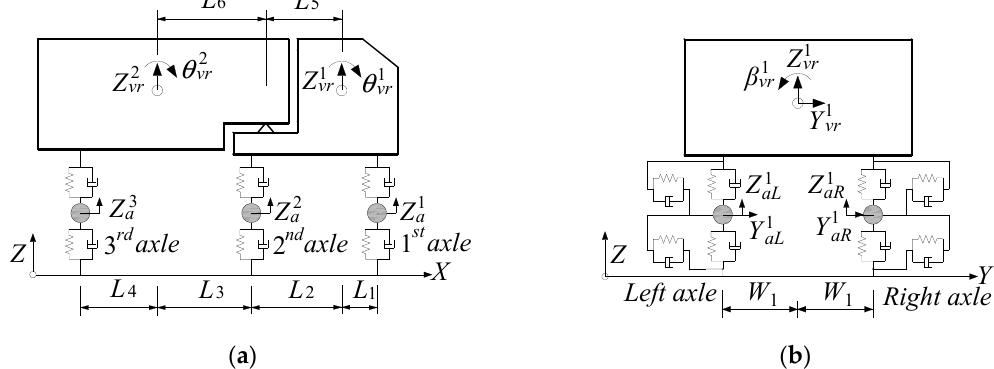
Figure 1. Numerical model of a 3-axle vehicle: ( a ) Elevation view; ( b ) side view.